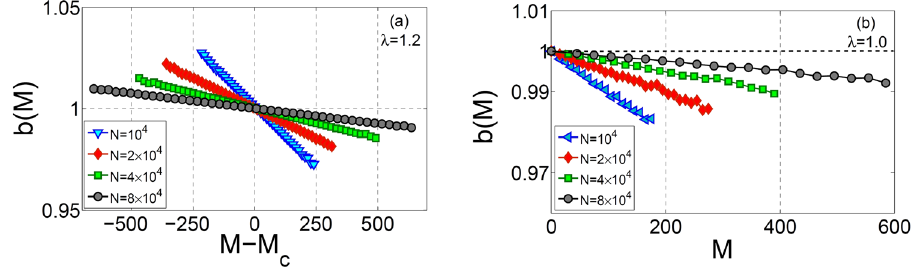
Figure 3. Activity dependent branching ratio for ( a ) λ = 1.2, ( b ) λ = 1 and different values of N = 10 4 , 2 × 10 4 , 4 × 10 4 , 8 × 10 4 .